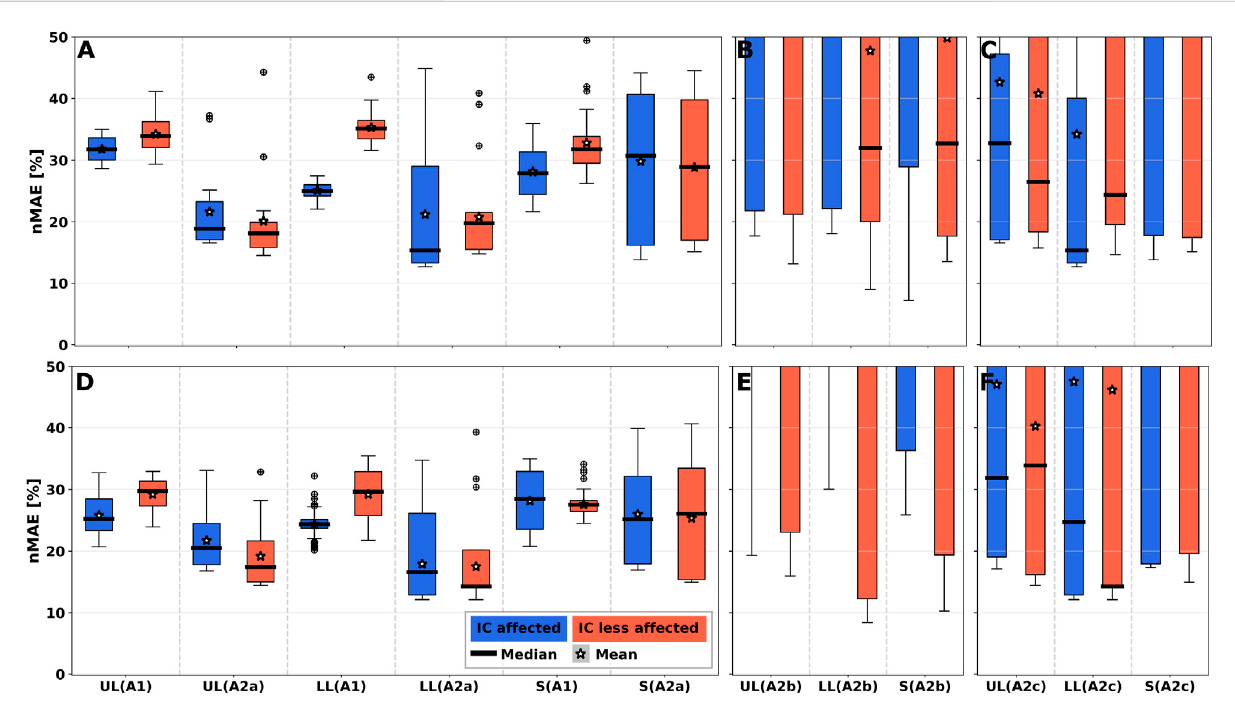
FIGURE 5 1-phase gait event nMAE of all simulated sensor positions summarised per body segment for all algorithms. nMAE axes were limited to highlight practically relevant sensor performances with nMAE below 50%. For full-range diagrams, please see Supplementary Figure S5. A1 shows larger nMAE in medians for all segments. (A – C) PRE intervention. (D – F) POST intervention. (A,D) User-dependent and sensor position-dependent parameterisation (Algo. A1, Algo A2a). (B,E) User-independent parameterisation by averaging parameters across training set patients (Algo. A2b). (C,D) User- dependent and sensor position-independent parameterisation by averaging parameters across body segments (Algo. A2c). UL: Upper leg; LL: Lower leg; S: Shoe.